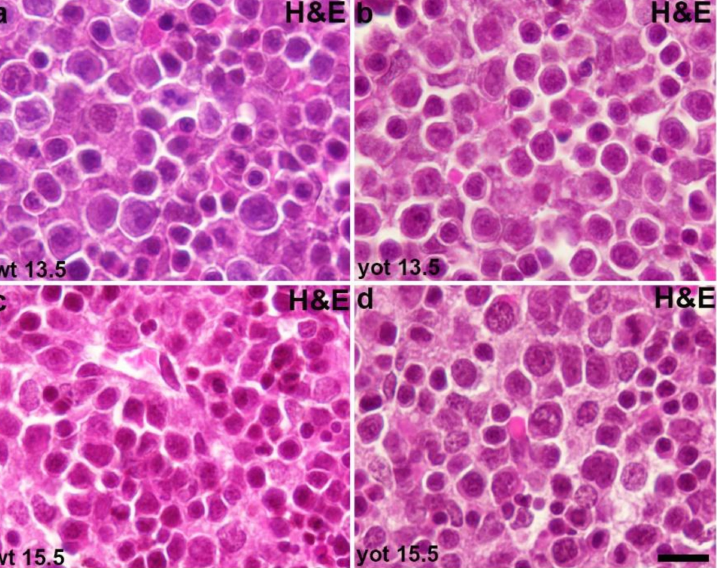
Figure 1. Hematoxylin-eosin (H&E) staining of the wt and yotari livers. H&E staining of the wt ( a ) and yot ( b ) livers at the embryonic day 13.5 (E13.5). H&E staining of the wt ( c ) and yot ( d ) livers at the embryonic day 15.5 (E15.5). The scale bar is 8 µ m, refers to all